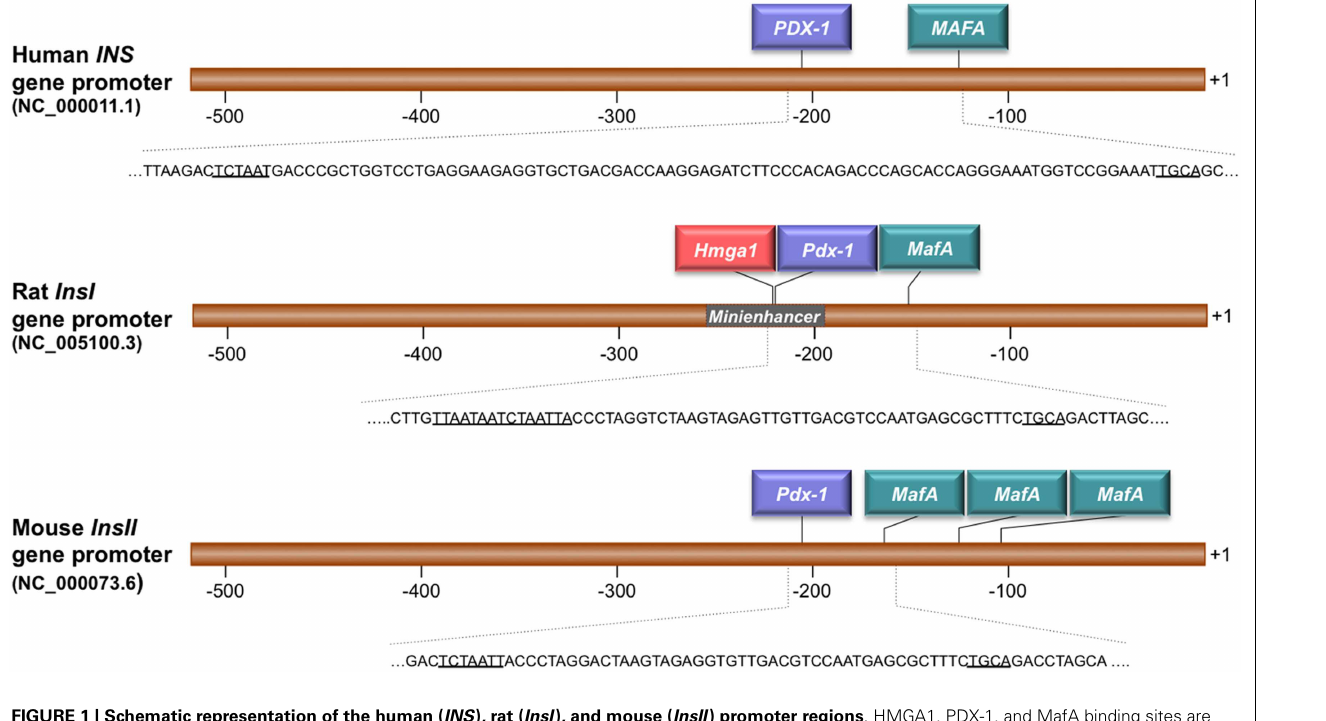
FIGURE 1 | Schematic representation of the human ( INS ), rat ( InsI ), and mouse ( InsII ) promoter regions . HMGA1, PDX-1, and MafA binding sites are underlined in each gene sequence.The numbers indicate positions in base pairs relative to the transcriptional start site ( + 1).The rat insulin mini-enhancer element E2A3/4 is